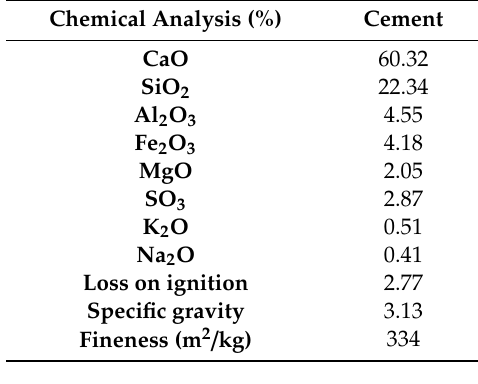
Table 4. Chemical compositions and physical properties of cement.